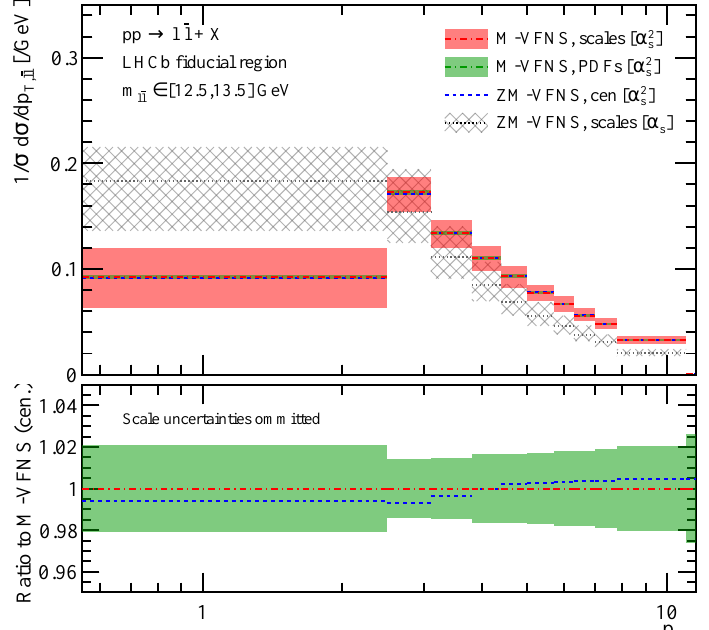
Figure 5: Differential prediction for the normalised p fiducial region for m (cid:96) ¯ (cid:96) ∈ [ 12.5,13.5 ]